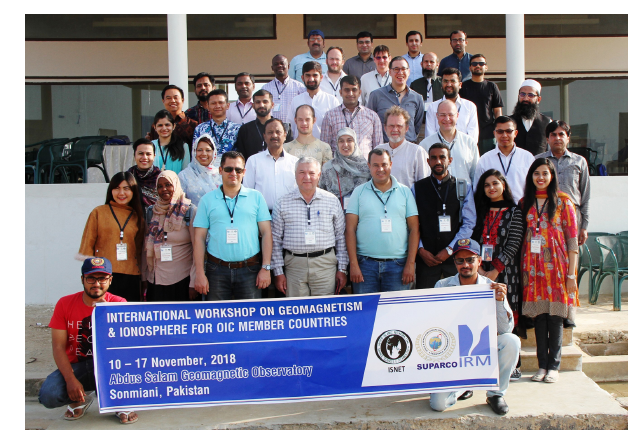
Figure 14. Four SUPARCO officials visited the Korean Space Weather Center to learn about space weather monitoring practices carried out in South Korea.